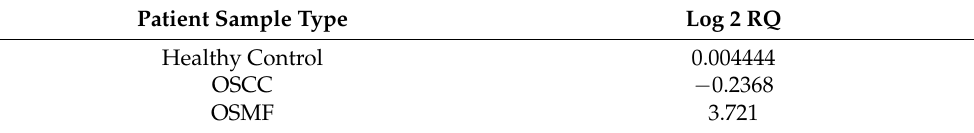
Table 4. Expression levels of OCT 3/4 in OSCC, OSMF and healthy control